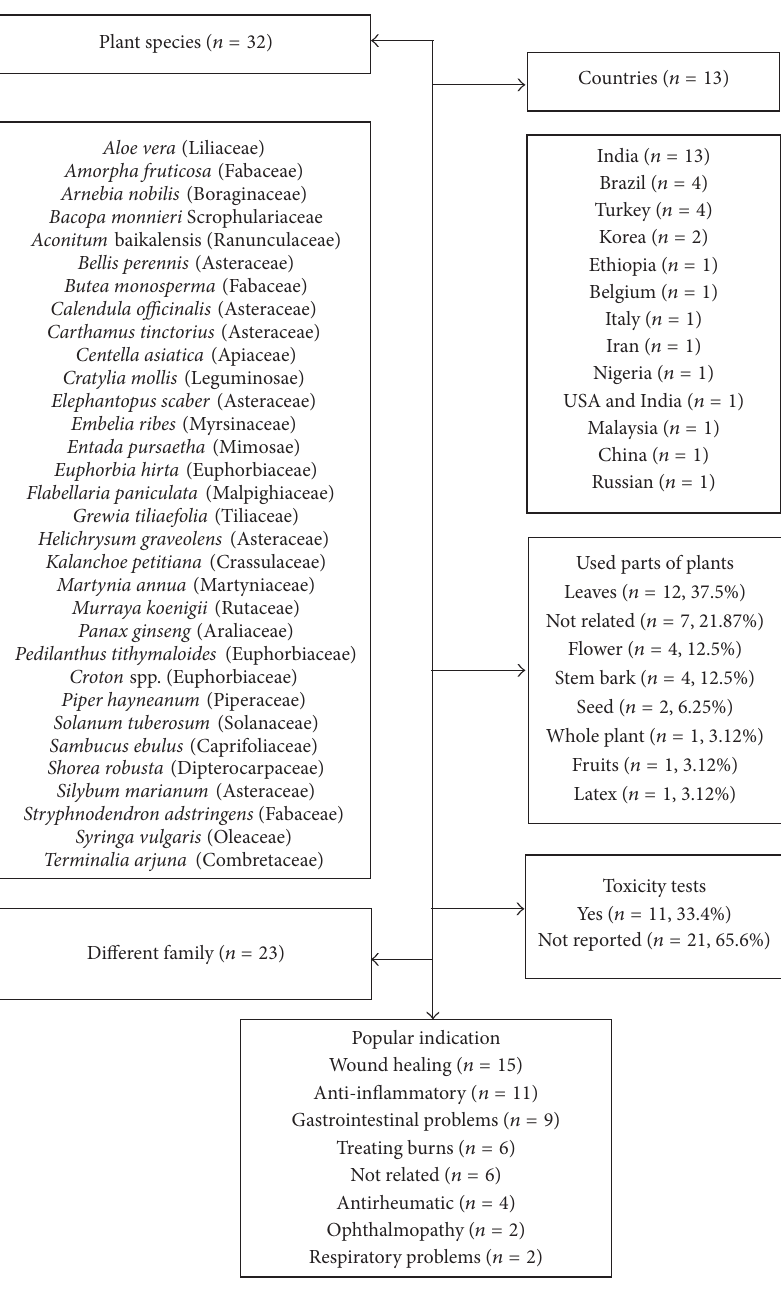
Figure 2: Summary of the studies describing the plants species, families, used parts of each species, toxicity tests, and popular indications. both (12.5%, 𝑛 = 4 ). Considering the animal strain, 65.7% were Wistar rats, 17.14% were Sprague Dawley rats, 11.42% were Swiss mice, and 5.71% were Hairless mice. Half of the experimental models used male animals ( 𝑛 = 16 ), 15.62% ( 𝑛 = 5 ) used females, and 18.75% ( 𝑛 = 6 ) used both sex. 15.62% ( 𝑛 = 5 ) of all studies did not report this information. The animals’ age ranged from 2 to 5 months for rats and from 8 to 12 weeks for mice; however 71.8% ( 𝑛 = 23 ) of the studies did not relate this information. The weight of rats ranged from 150 to 400 g and the mice weighted between 18 and 40 g, and only 2 studies (6.25%) did not report this